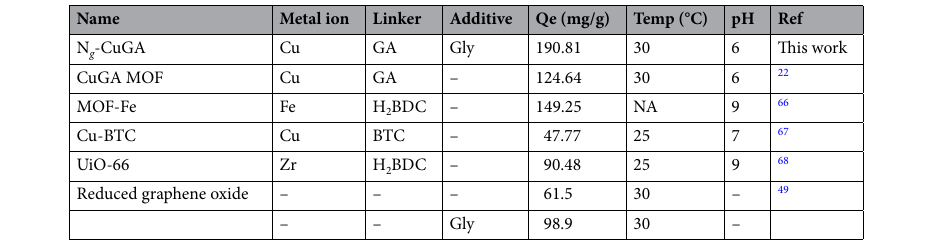
Table 5. MB adsorption capacity on various metal-linker coordination adsorbents.